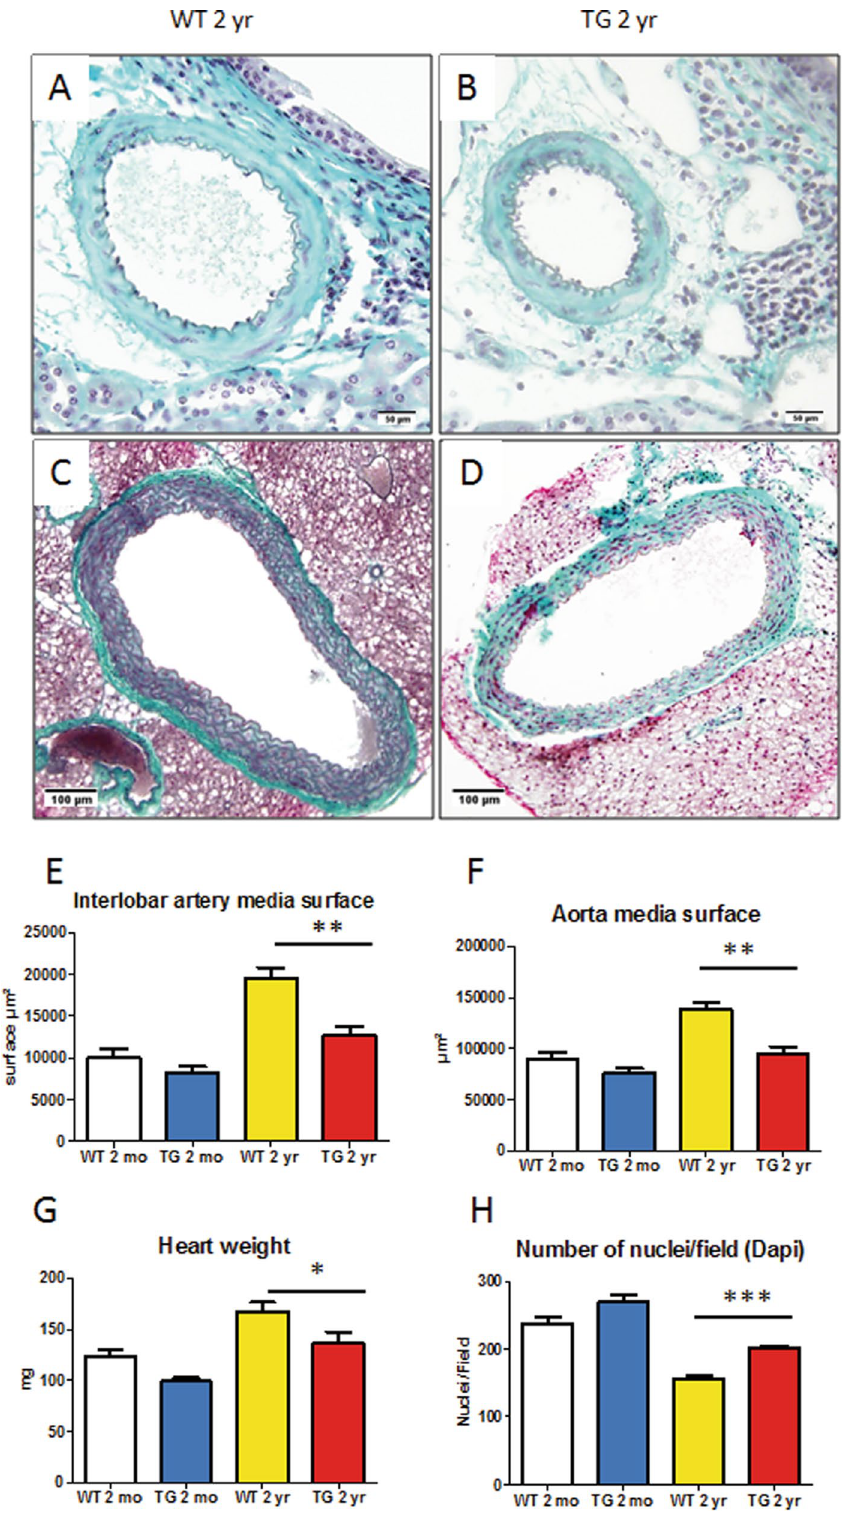
Figure 4. Calpastatin overexpression protects against cardiovascular aging. Mean media surface of interlobar arteries was significantly less increased in CalpTG (TG) mice at 2 years in comparison to WT mice ( A,B,E , ** p < 0.01, n = 10/group, magnification × 400). Similarly, aorta remodelling was less important in CalpTG mice ( C,D,F , ** p < 0.01, n = 10/group, magnification × 200). Heart weight increased with aging but less in CalpTG mice than in WT animals ( G , * p < 0.05, n = 10/group). This increase in heart weight was due to cellular hypertrophy since the number of nuclei per field at 400x magnification was significantly lower in WT in comparison to CalpTG mice ( H , *** p < 0.001, n =